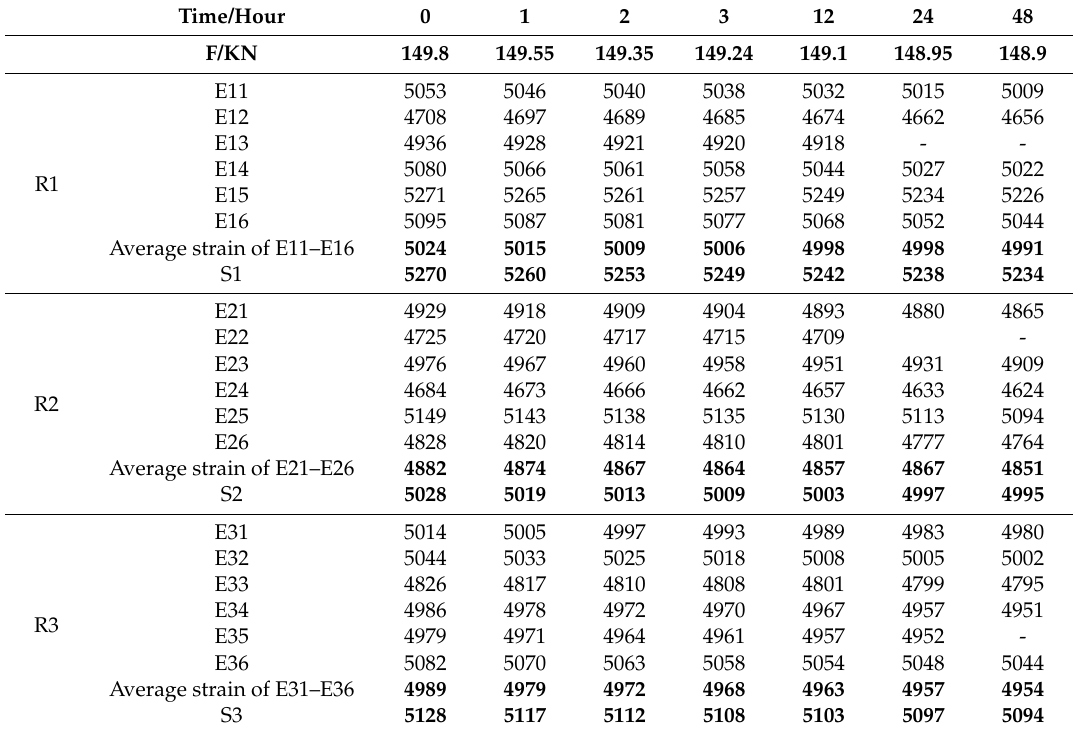
Table 3. The monitored strains of the strand at Step II. (Unit: µε ).